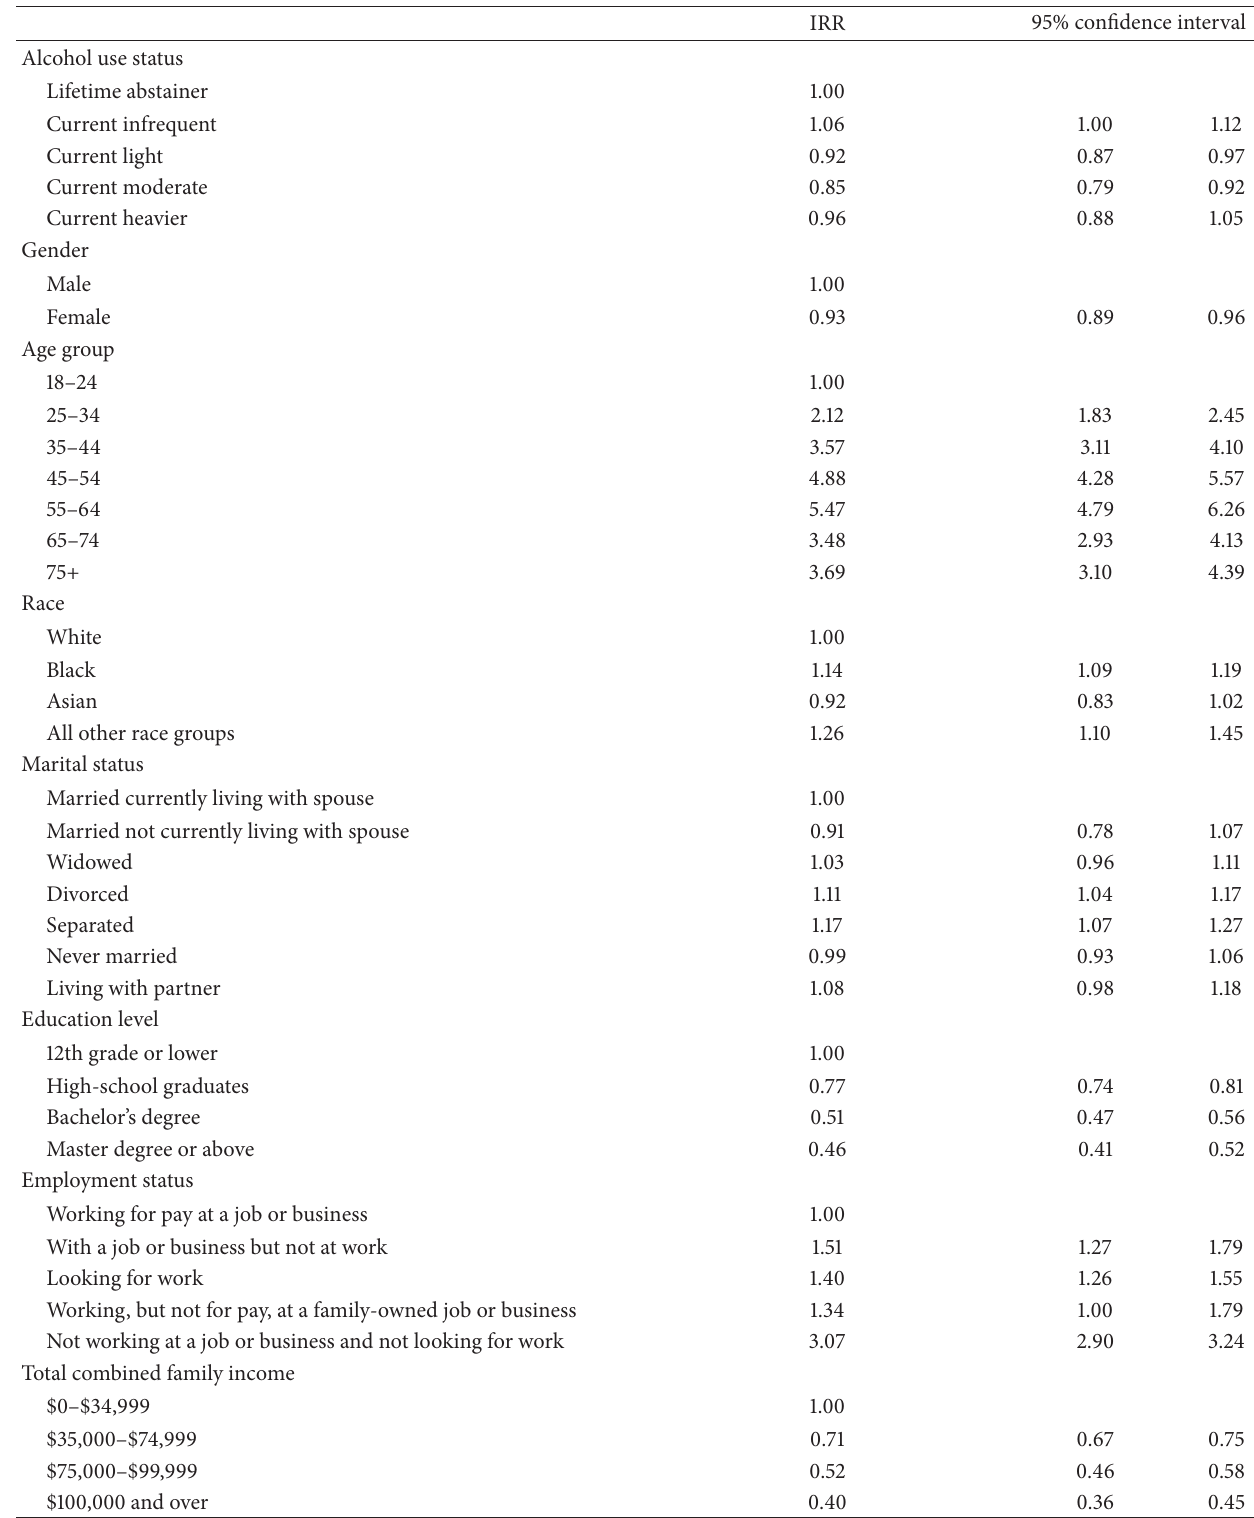
Table 5: Association between alcohol use and health status using the traditional approach plus intention-to-treat analysis, all controlled confounders listed (RR: relative